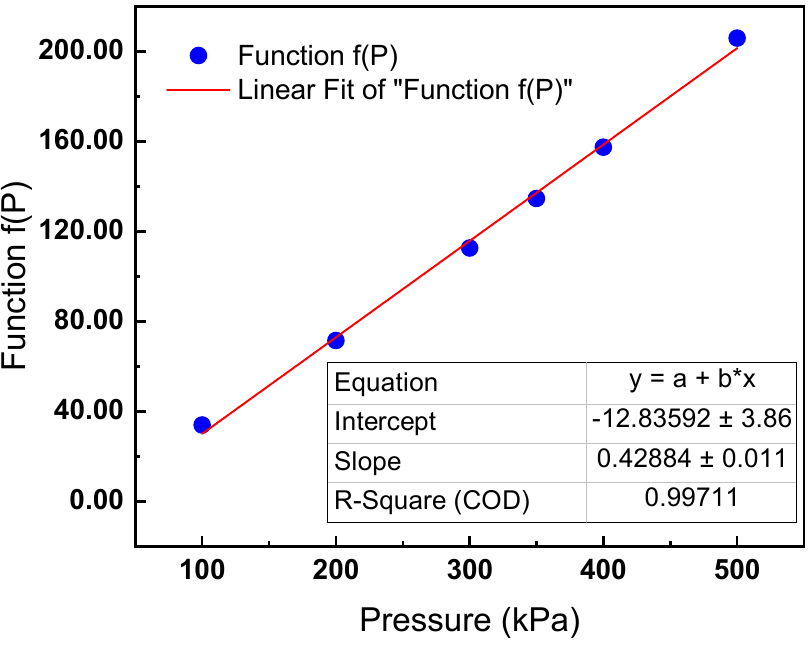
Figure 3. Function f(P) changes along with gas pressure.